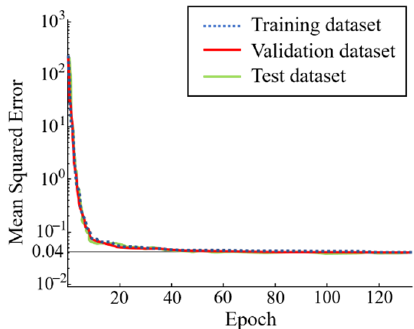
Figure 13. The learning curve of the ANN model.